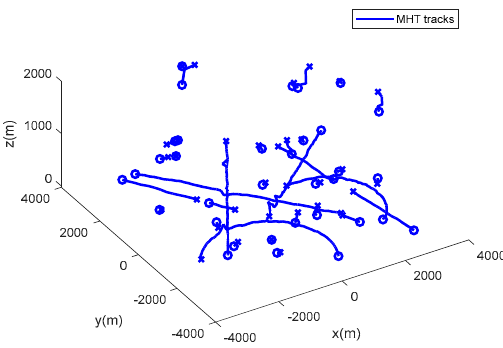
Figure 7. The estimated trajectories of the multiple hypothesis tracker using validation gate with motion direction constraint (MHT-MDC) in scenario 1.